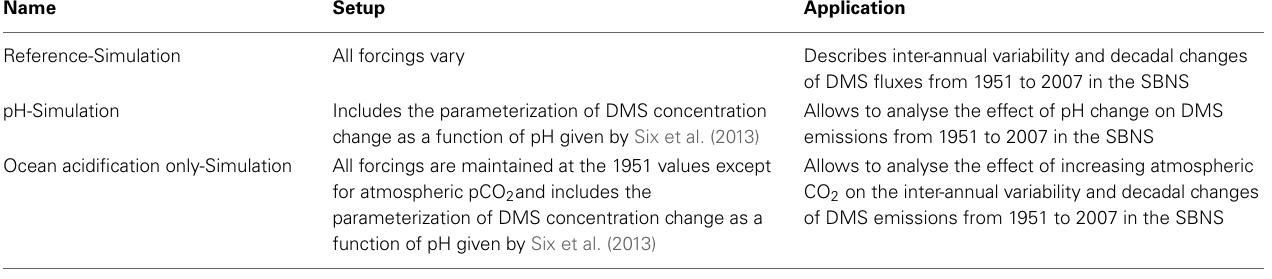
Table 1 | Description of the R-MIRO-BIOGAS simulations.